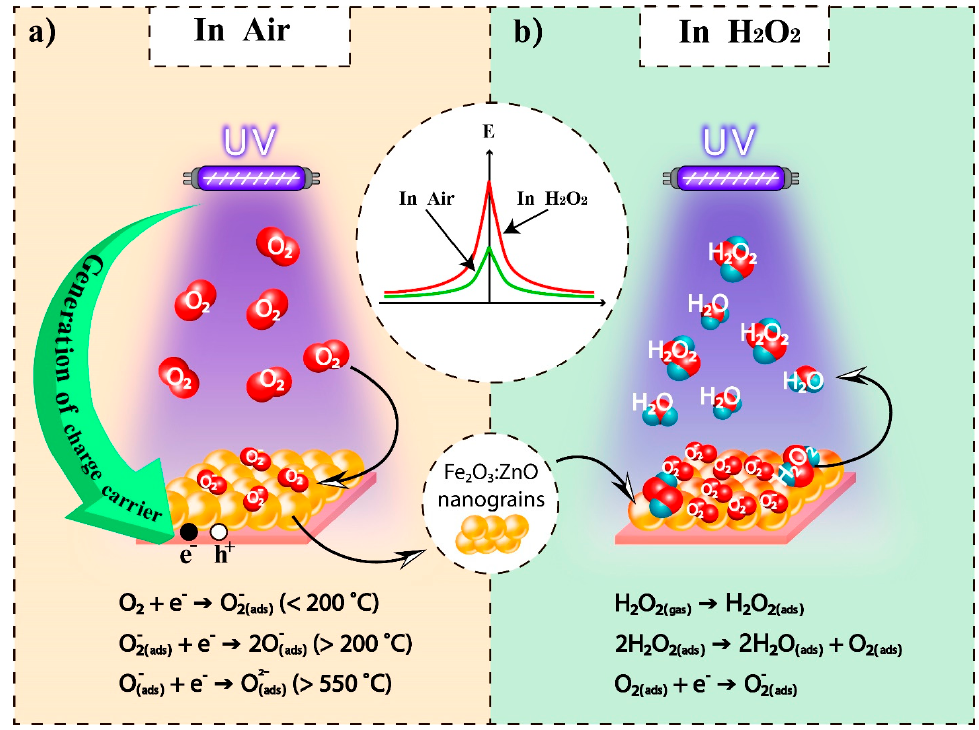
Figure 13. The schematic diagram of the proposed HPV sensing mechanism for the Fe 2 O 3 :ZnO sensor under UV irradiation in the air ( a ) and in HPV environment ( b ).